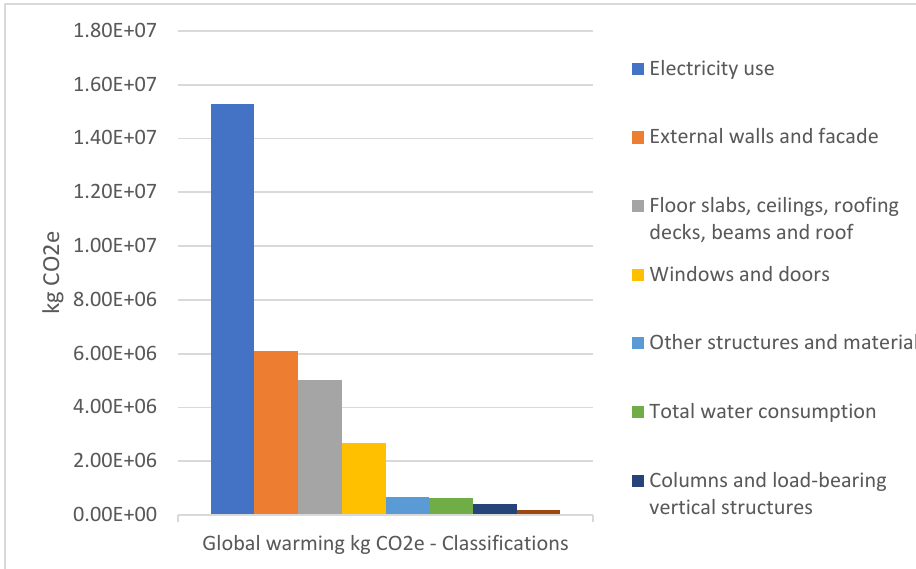
Figure 4. Embodied carbon based on life cycle stages.